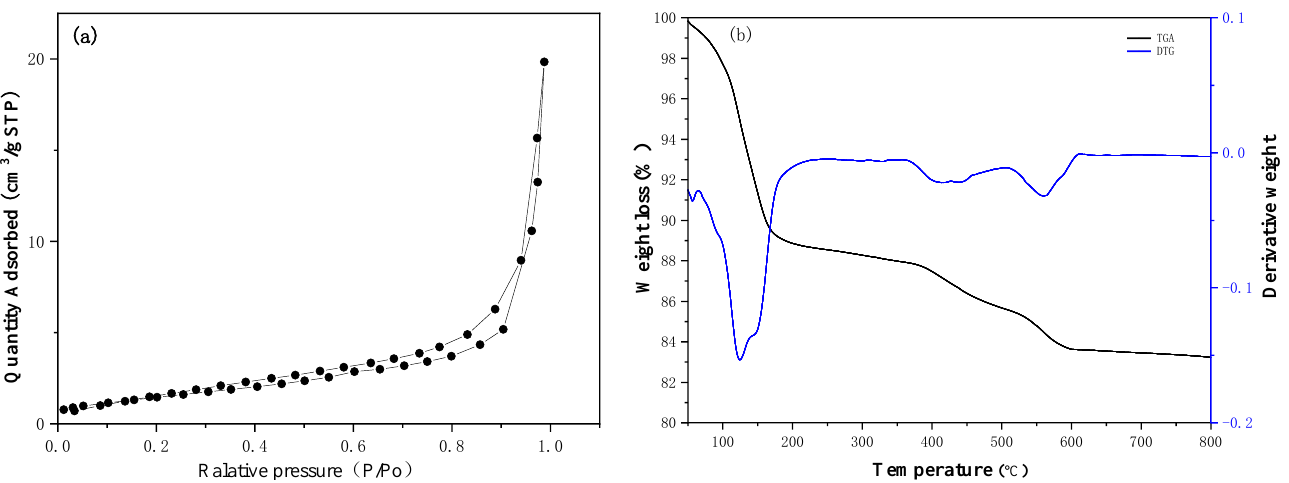
Figure 3. The N 2 adsorption – desorption curve of the samples ( a ) and the TGA measurement of the DN-350 catalyst ( b ). Table 2. EDX analysis of DN-350 catalyst.